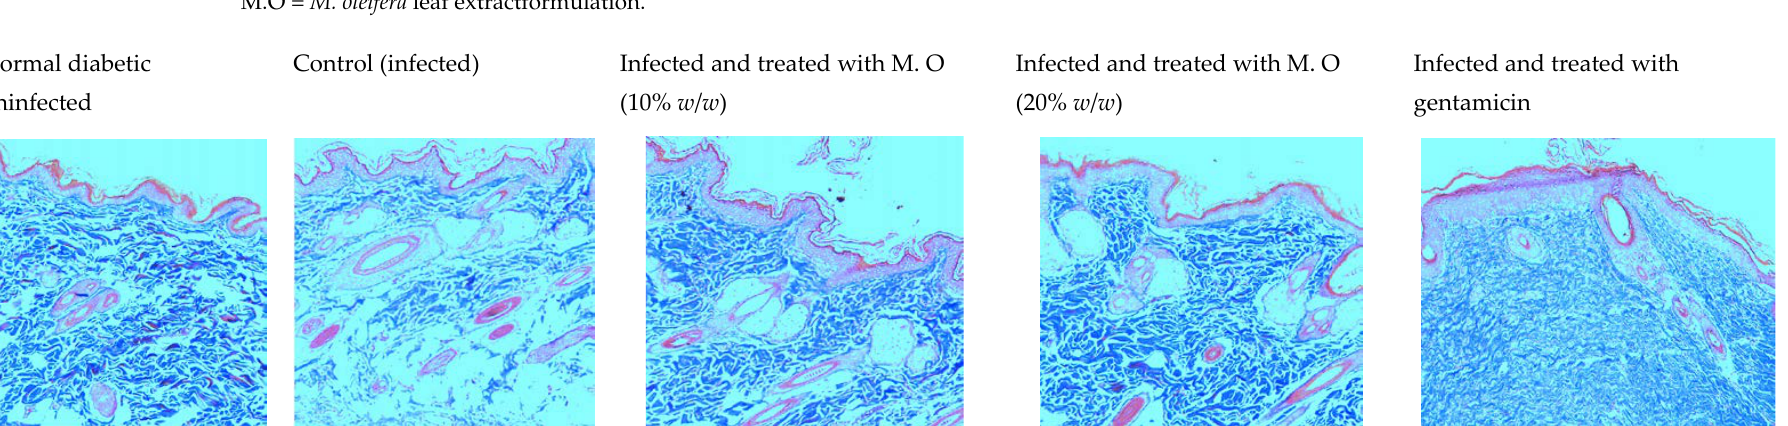
Figure 10. Histology of skin from diabetic animals infected with P. aeruginosa stained with H & E stain (100 × ). Photomicrographs showing regenerated epithelium in different groups. Black arrows show the epidermis, yellow arrow shows capillaries, and red arrows show inflammatory cells. In normal animals, the height of the epidermis is high, with a number of capillaries and few inflammatory cells. In infected animals, the epidermal height was noticeably reduced, with fewer capillaries and more inflammatory cells. The epithelial height, capillaries and the number of inflammatory cells were more in the M. oleifera - and gentamycin-treated animals. M.O = M. oleifera leaf extractformulation.